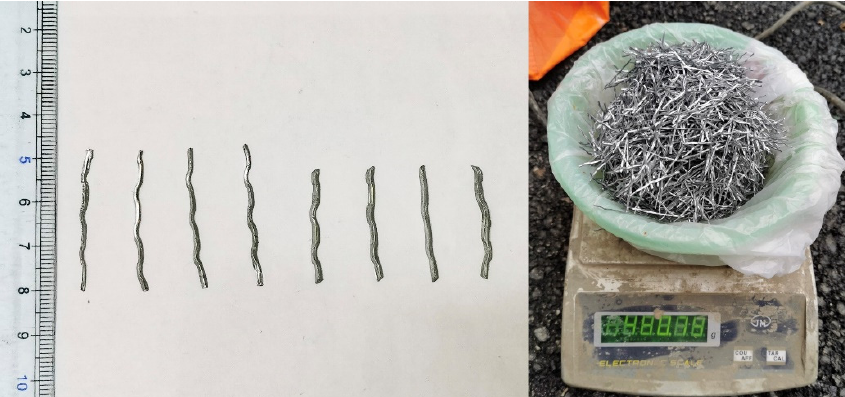
Figure 1. Appearance of the steel fiber. Table 1. Steel fiber parameters.